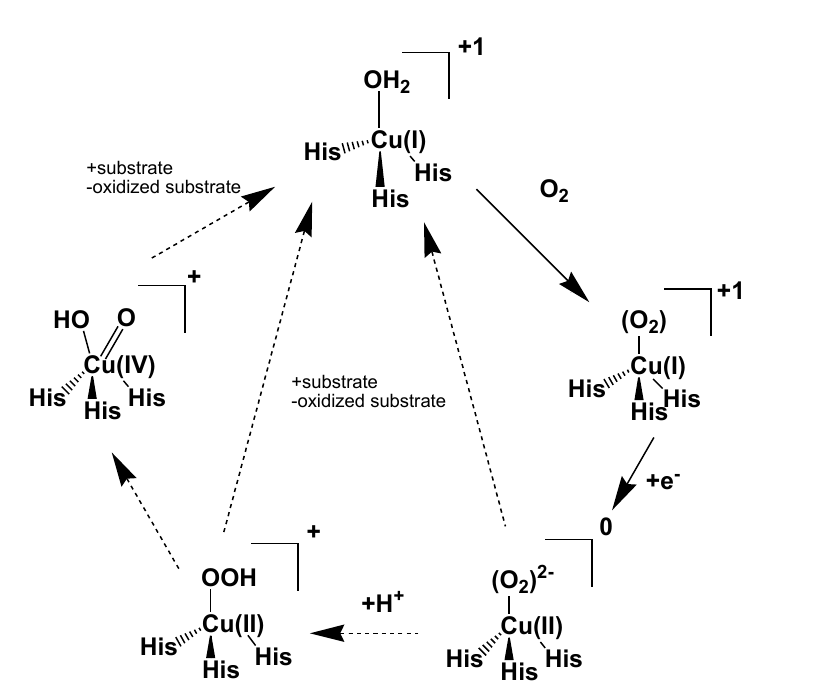
Figure 1. Catalytic cycle that may in principle be operating for copper-containing oxygenases. Dashed arrows indicate alternative pathways which may all lead to product. The protein-derived ligands are considered to be three histidinines, as seen in some but not in all dioxygen-activating copper